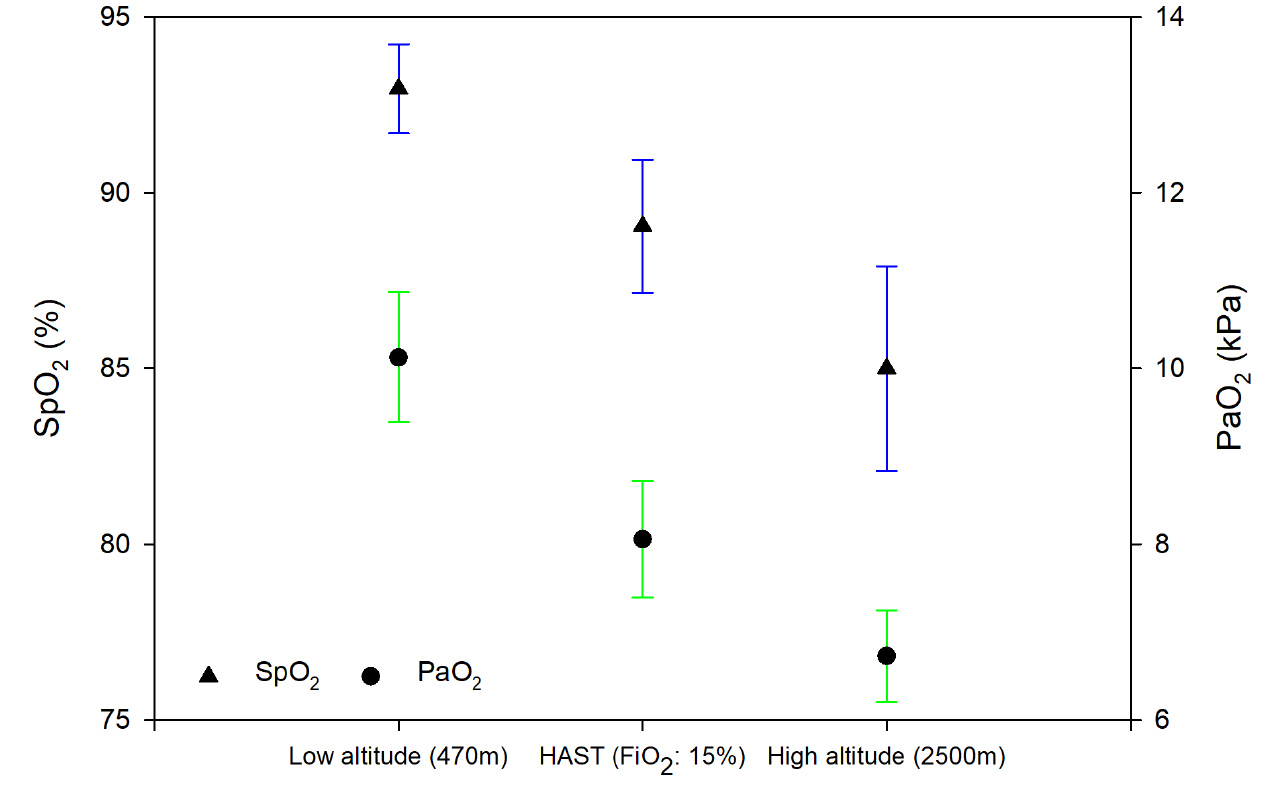
Figure 2. SpO 2 (triangles, blue) and PaO 2 (circles, green) in normobaric normoxia (470 m), normobaric hypoxia (470 m) and at high altitude (2500 m). HAST = High altitude simulation test. Measurements are summarized as means and 95% Confidence Intervals. Data are computed from a mixed-effect regression model with fixed effects variables as time, age, gender and New York Heart Association class.